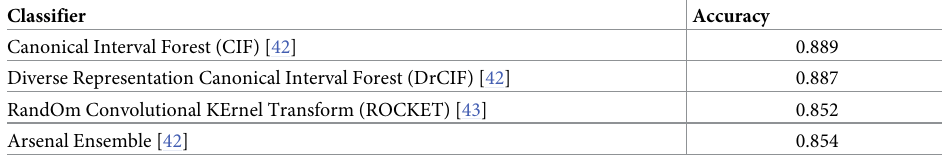
Table 2. Time series classification methods with details on classifier types and their corresponding